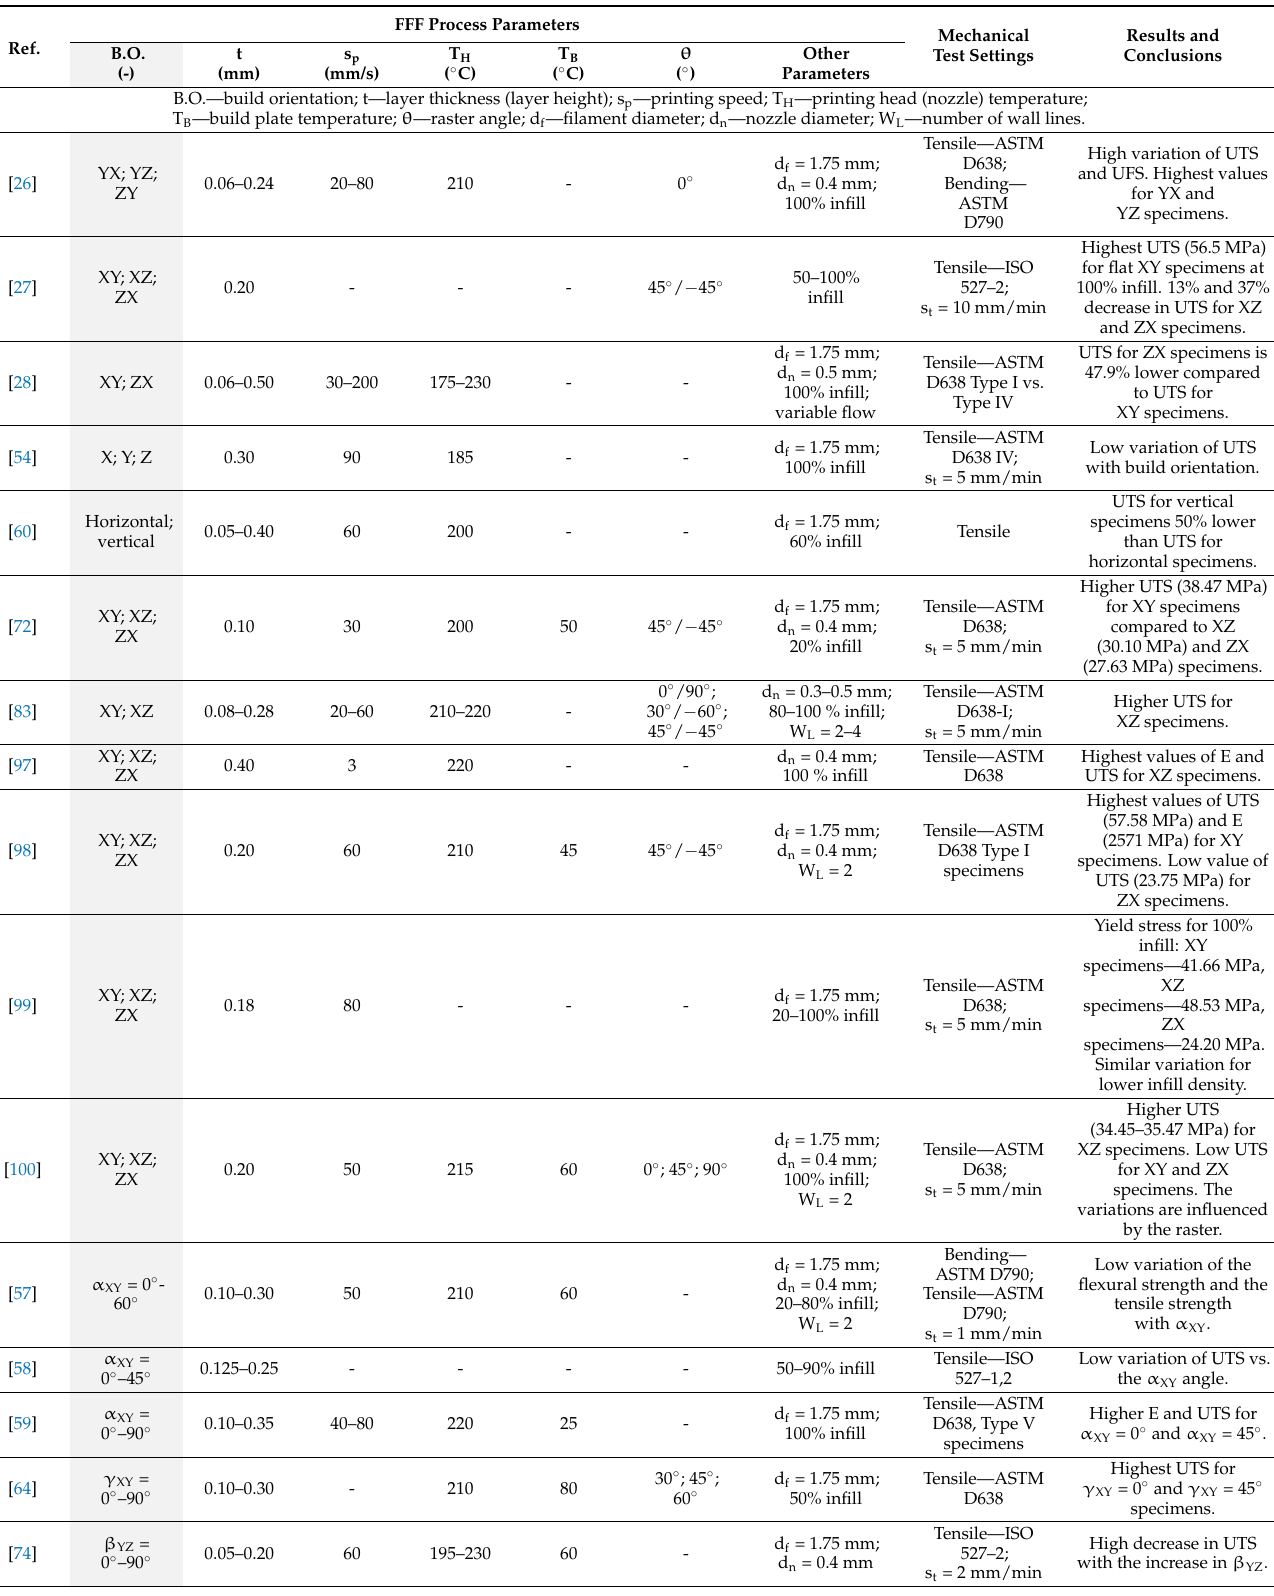
Table 5. The influence of the build orientation and the printing orientation angle on the mechanical properties of FFF-printed